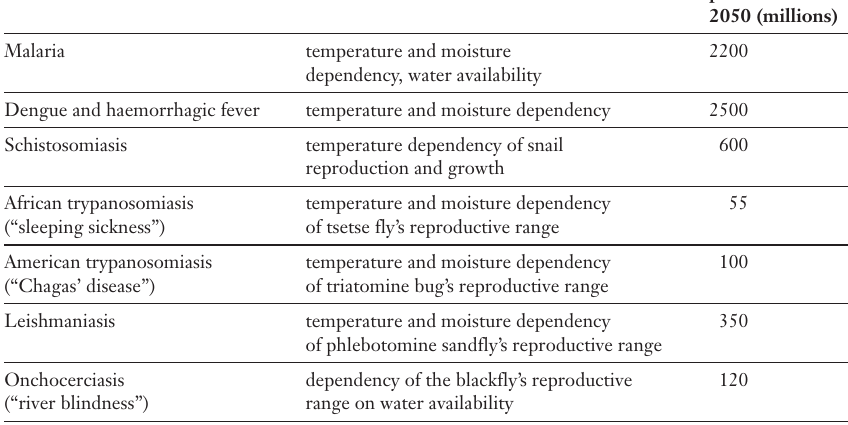
Climatic factors influ- encing the range and propagation of vec- tor-borne and water- borne diseases, and the probable human impacts of these dis- eases as a result of climatic change by 2050 (adapted from WHO,